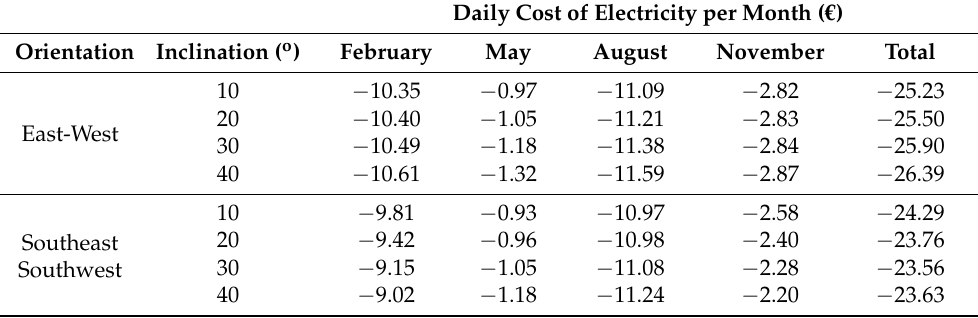
Table 3. Daily cost of electricity per month for medium-consumption households when combining